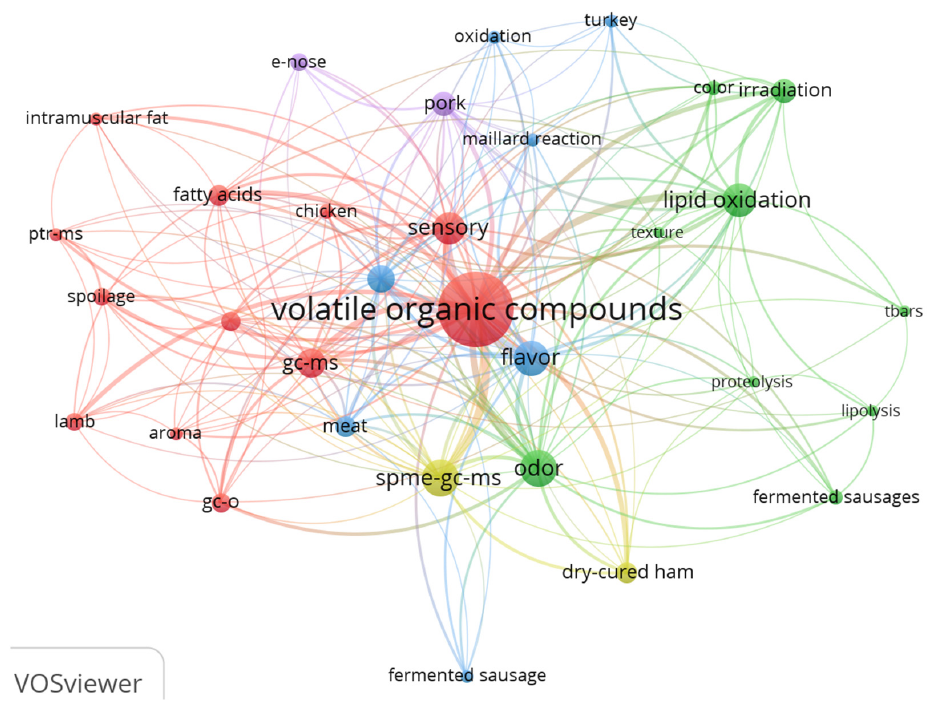
Figure 4. Keyword network for the volatile organic compounds of meat (32 key words with co-occurrences greater than 8 extracted from the 1354 selected authors’ keywords).